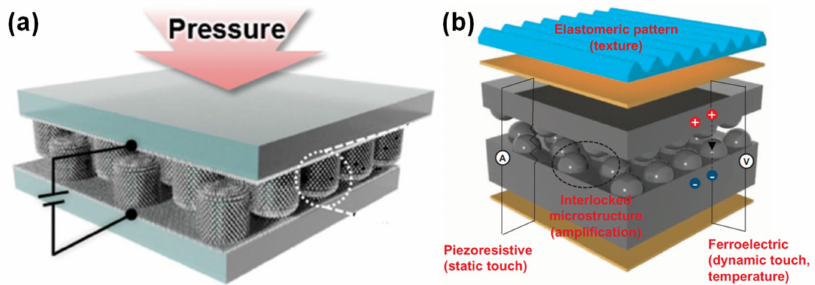
Figure 6. Piezoresistive and piezoelectric e-skin sensors developed by Hyunhyub Ko and co-workers in ( a ) 2015 [87] (Copyright © 2020 WILEY-VCH Verlag GmbH & Co. KGaA, Weinheim, Germany) and ( b ) 2015